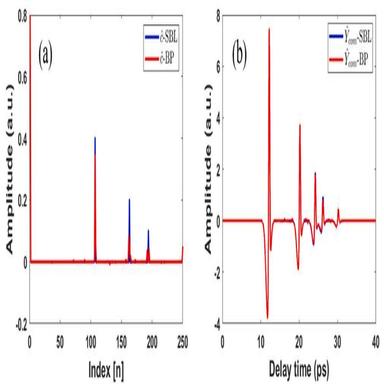
The spectrum localization results for the dispersive THz TOFT signal in a) by SBL and BP. (a) The sparse weight vector reconstructed by SBL and BP; (b) The dispersion compensation results by SBL and BP.